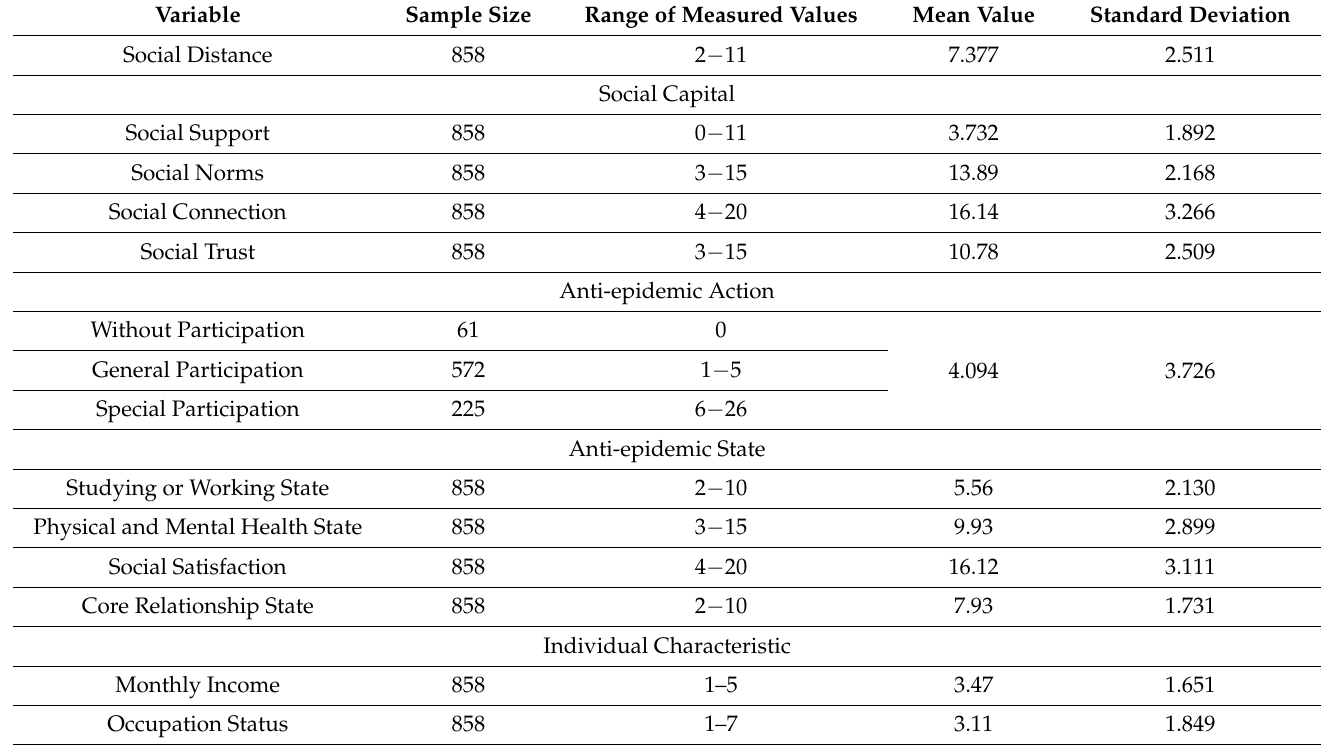
Table 2. Statistical Analysis of Variable